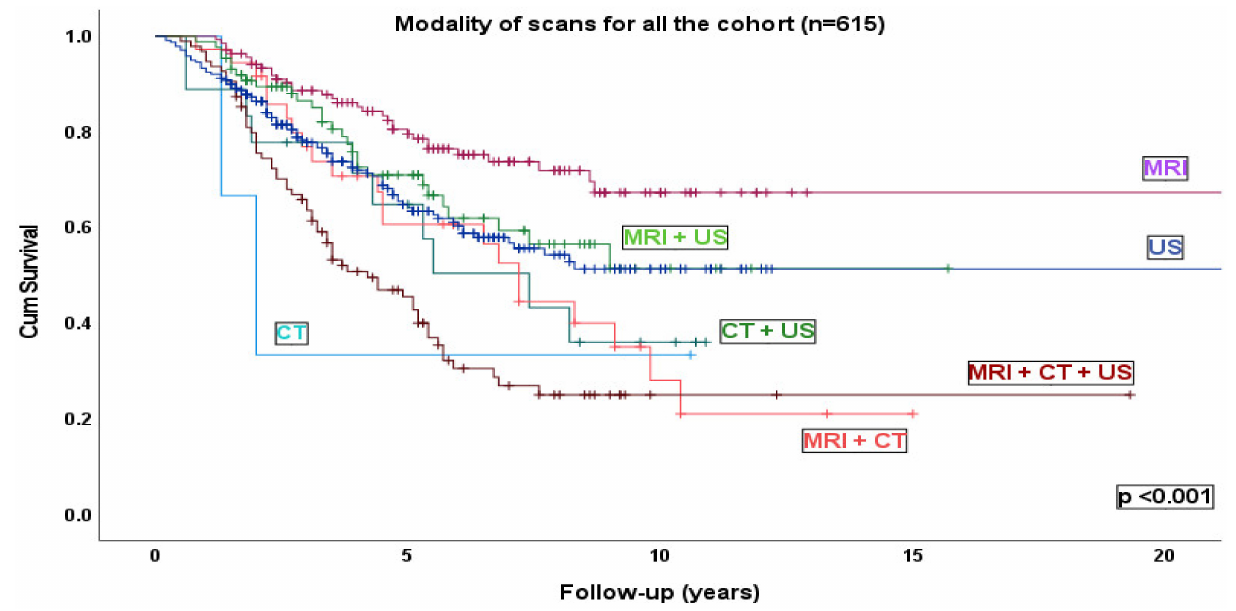
Figure 2. Kaplan–Meier survival curve and table where all the patients were stratified according to modality of scan performed. MRI: 137 patients underwent 983 scans; CT: 3 patients underwent 7 scans; US: 239 patients underwent 515 scans; MRI + CT: 36 patients underwent 400 scans; MRI + US: 87 pa- tients underwent 644 scans; CT + US: 18 patients underwent 84 scans. MRI + CT + US: 95 patients underwent 1223 scans. Number of events indicates the number of deaths. Table 2. Type of scans undertaken in the 615 UM patients, and the associated